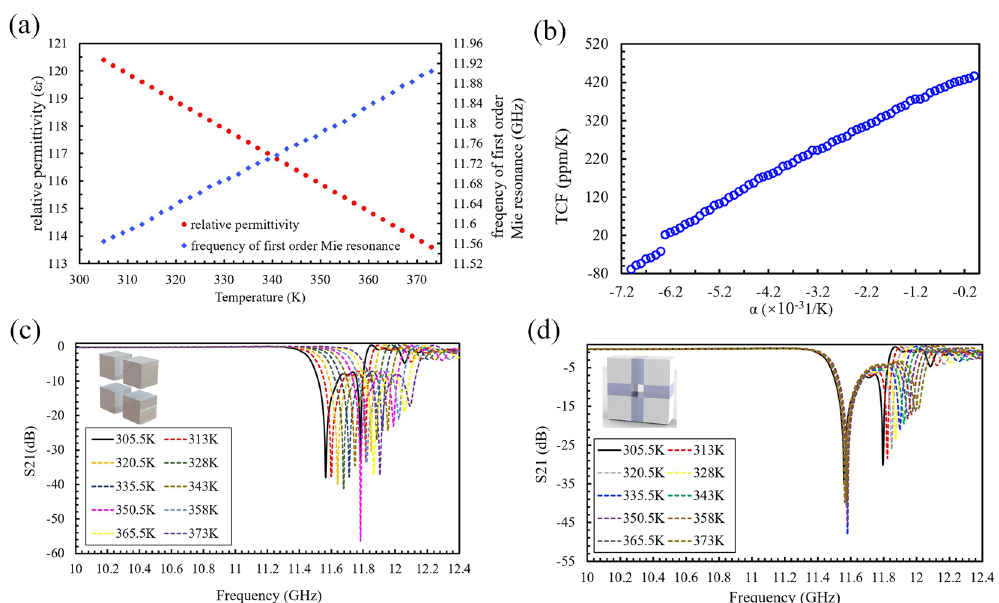
Figure 3. ( a ) Calculated relationship between the relative permittivity and temperature (red point curve) and the frequency of the first order Mie resonance and temperature (blue elliptical dot curve). ( b ) Calculated effective TCF of the meta-atom versus the thermal expansion coefficient of the intermediate layer. ( c,d ) The shift of the first order resonance frequency for the meta-atom ( c ) without elastic intermediate layer, and ( d ) with an intermediate layer ( α in = − 6.35 × 10 − 3 K − 1